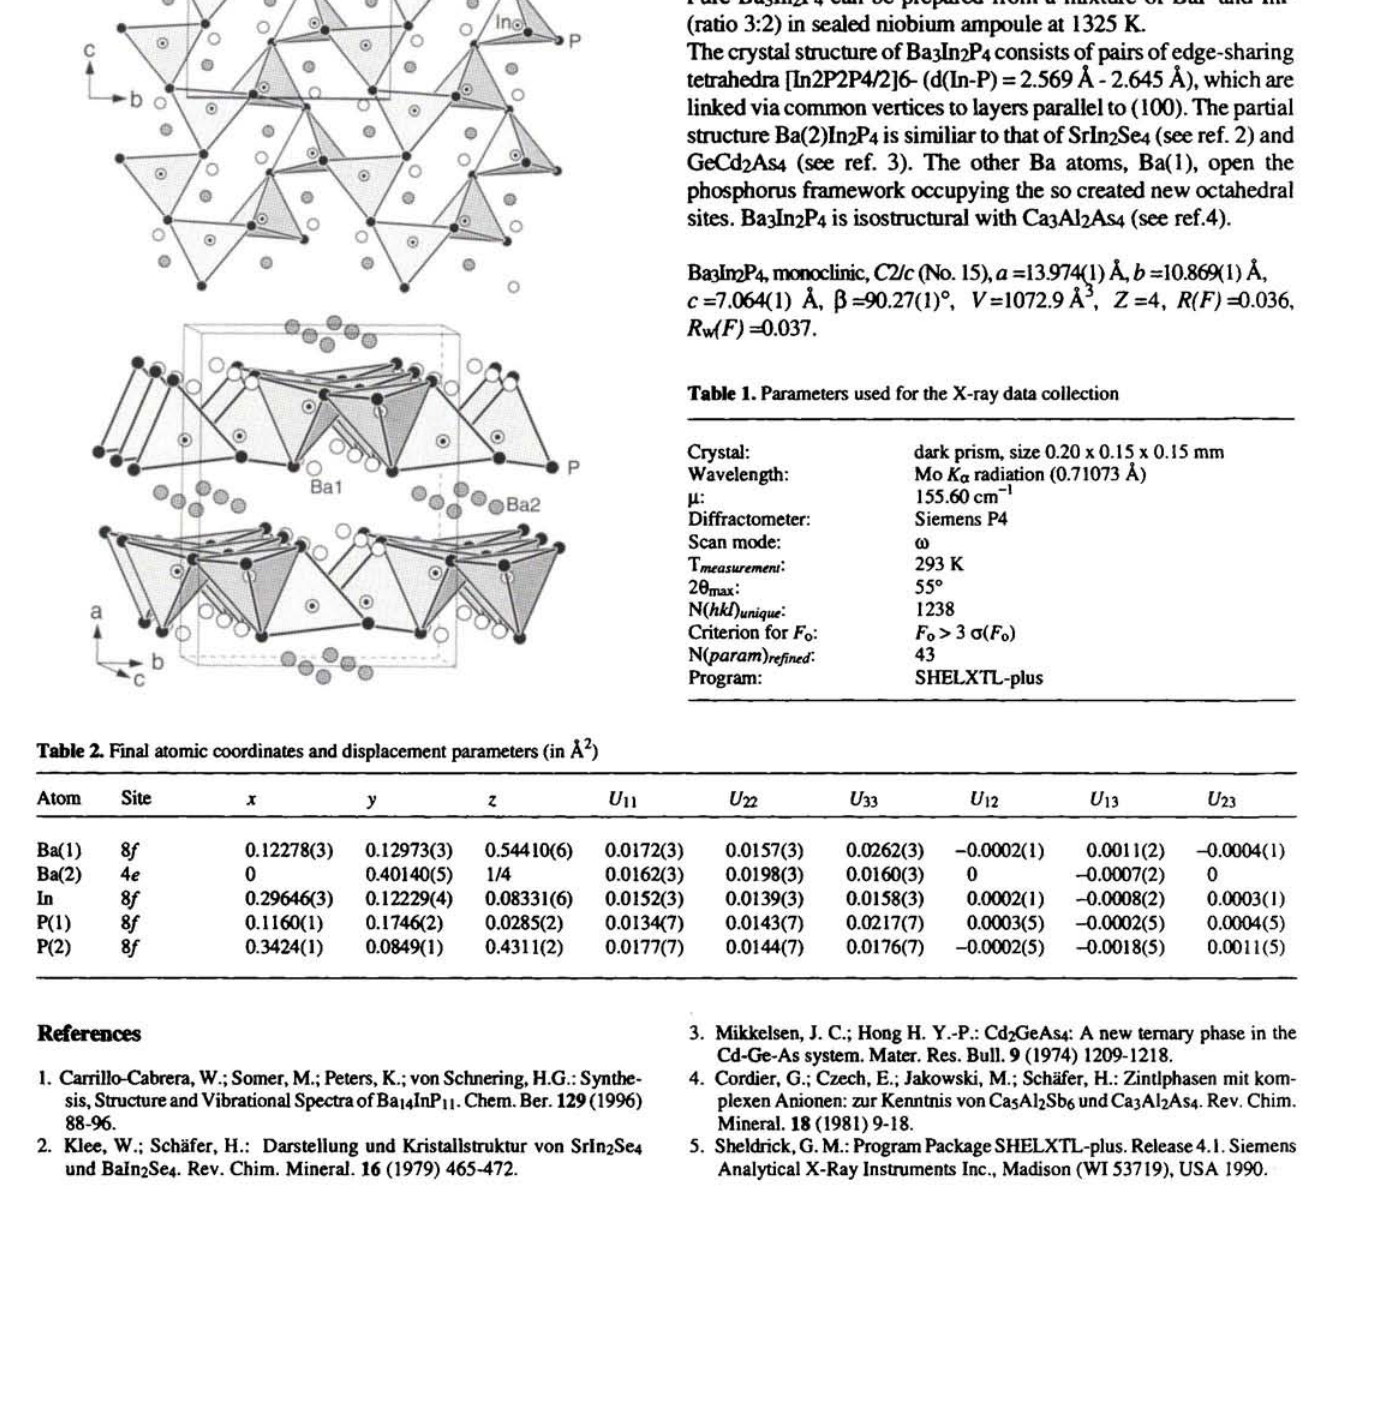
Table 2. Hnal atomic coordinates and displacement parameters (in